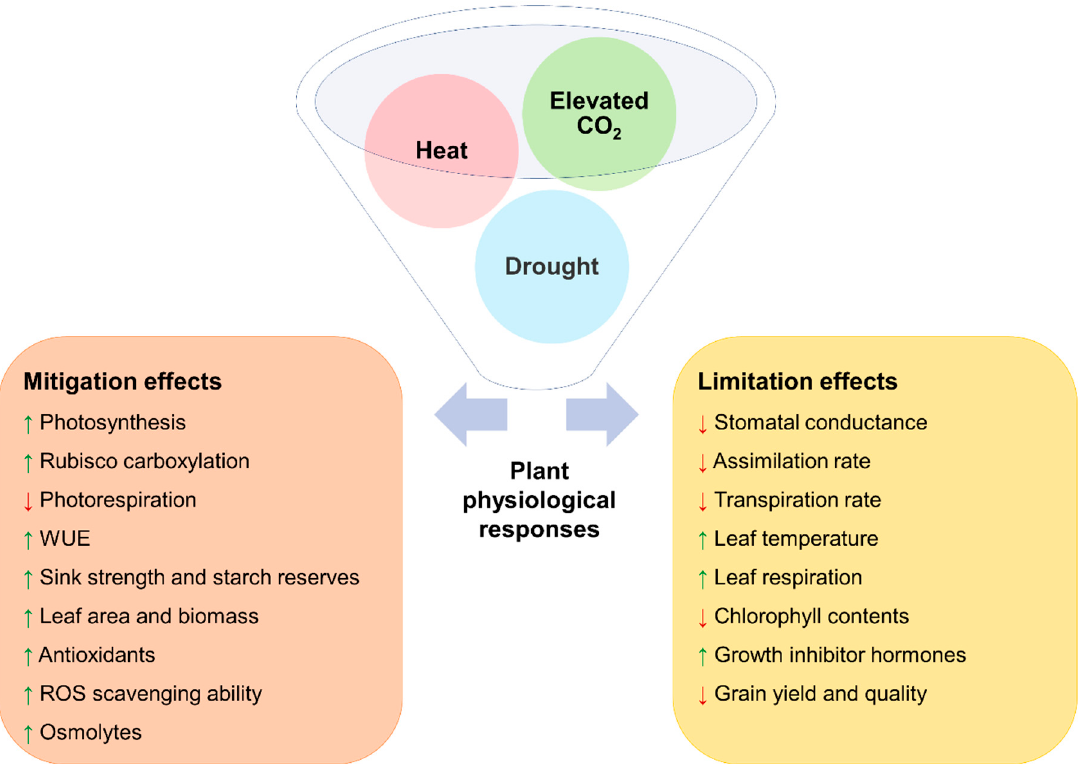
Figure 2. The mitigation and limitation effect under combined elevated CO 2 , drought, and heat stress on the main physiological and biochemical responses in plants.